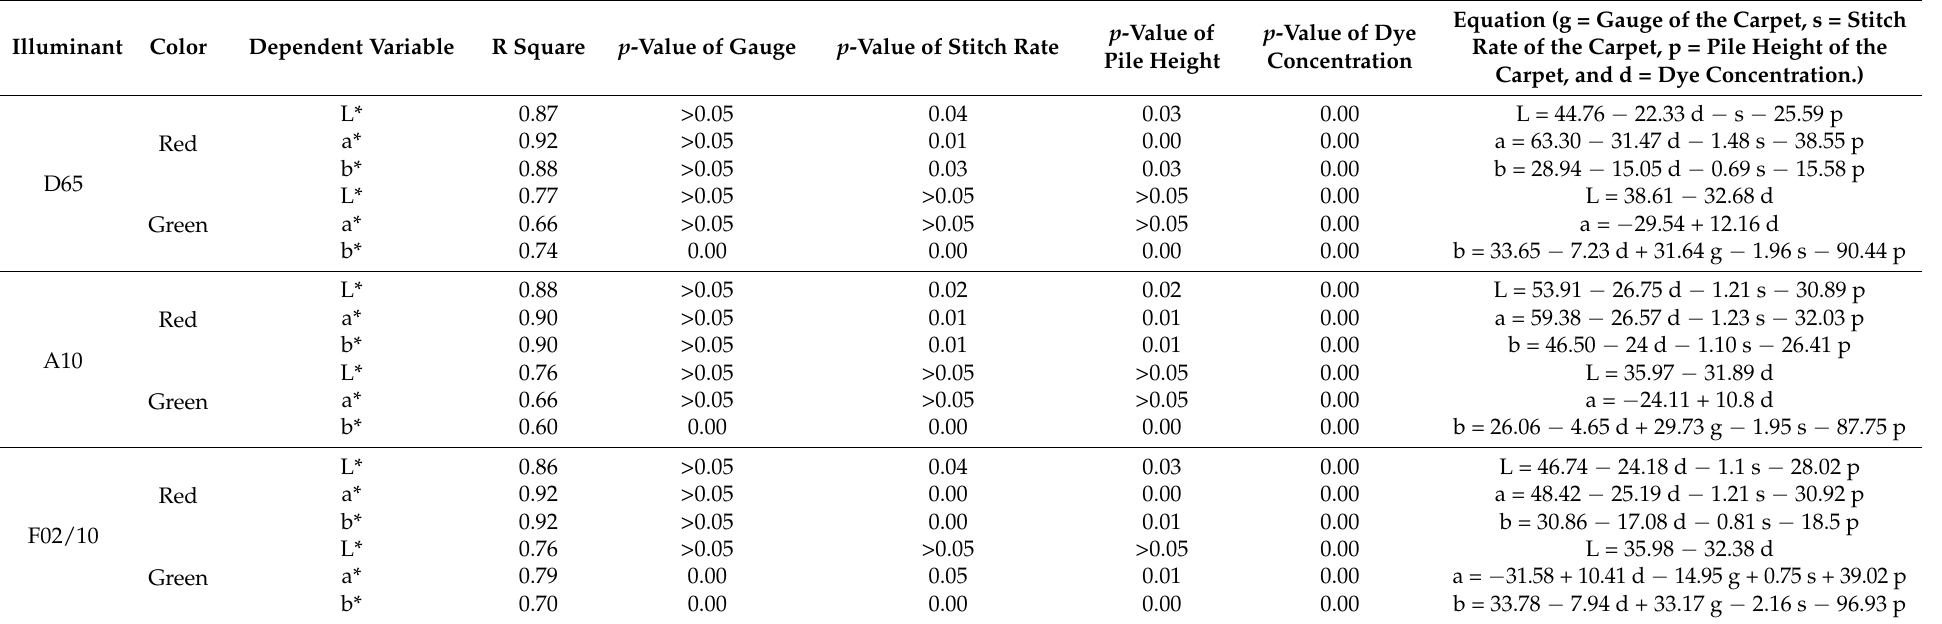
Table 7. Summary of the outcome of the regression analysis.